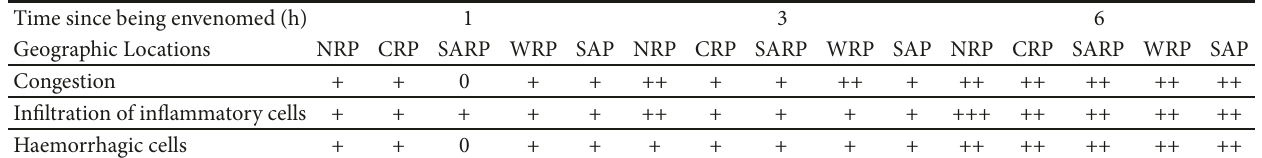
Table 3: Major histopathological changes in lung tissues by N. naja venom from distinct geographic origins in Sri Lanka. Score: 0: absent; +: mild; ++; moderate; and +++: severe [45]. Time since being envenomed (h) 1 3 6